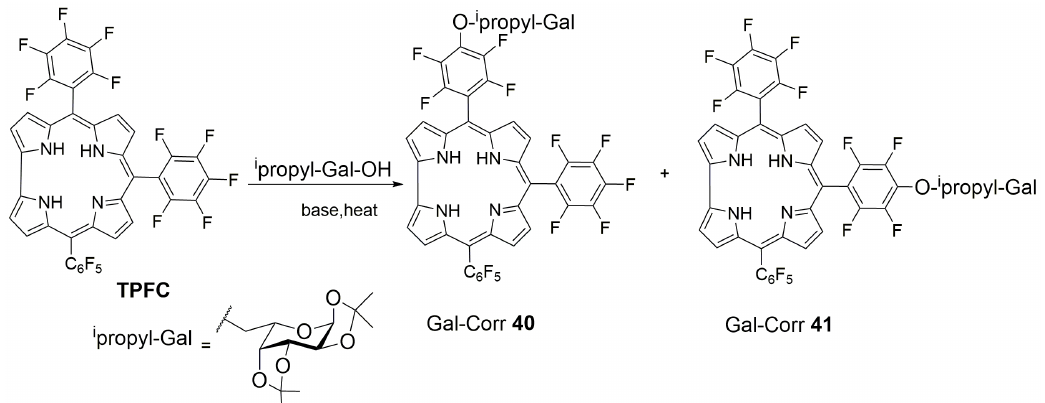
Figure 33 - Synthesis of pentafluorophenylcorrole-D-galactose conjugates Gal-Corr 40 and 41 .